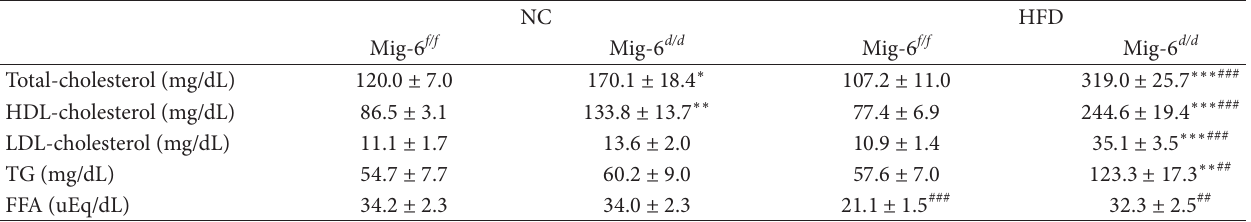
Table 1: Concentration of plasma biochemical parameters in Mig-6 f/f and Mig-6 d/d mice and the effects of high fat